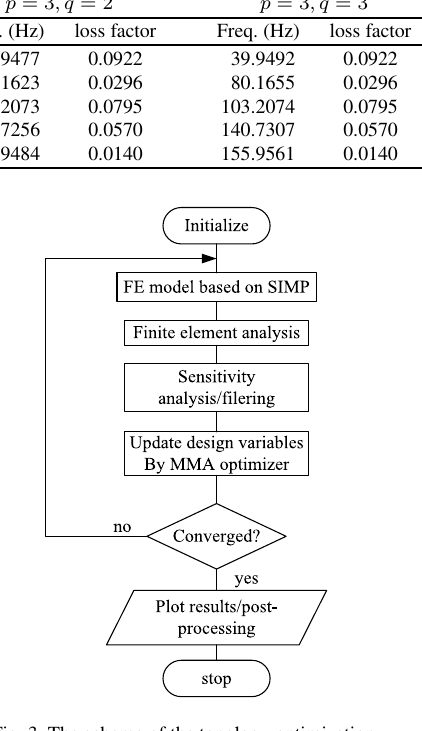
Fig. 2. A clear 0–1 design with PCLD partially covered on plate. Fig. 3. The scheme of the topology